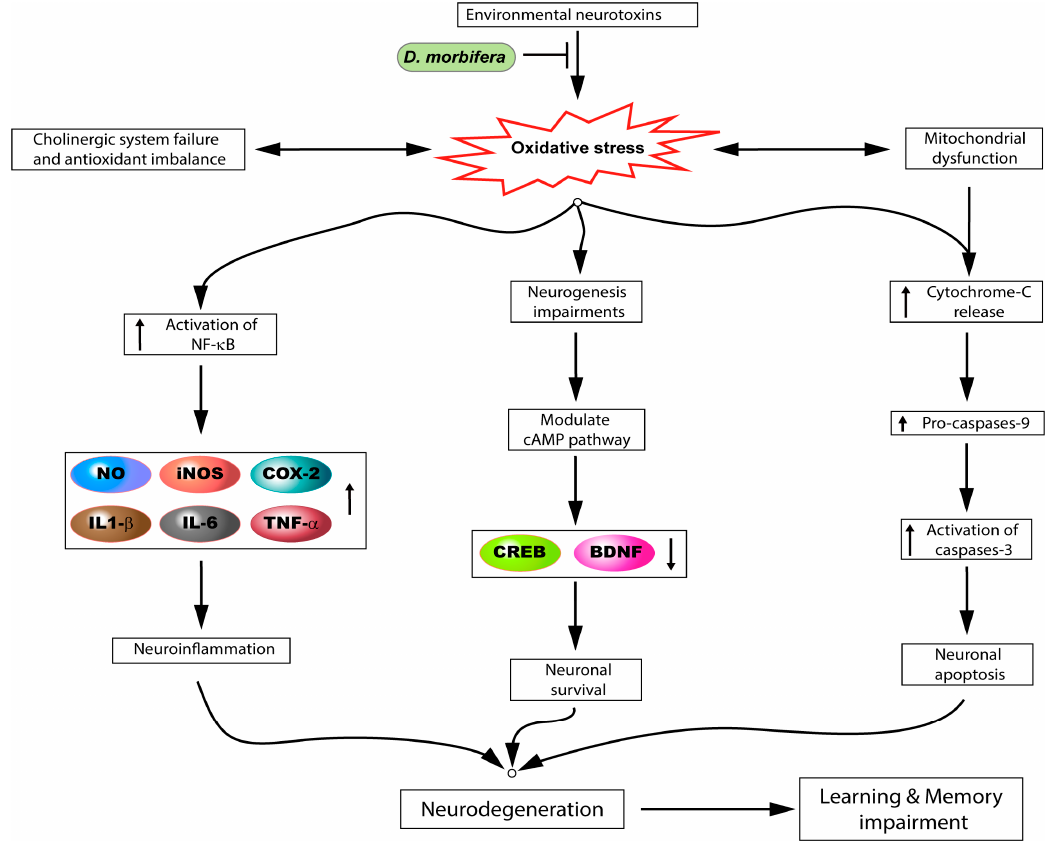
Figure 3. Neuroprotective and memory enhancing effect on D. morbifera . MAPK: mitogen-activated protein kinase; NF κ B: Nuclear factor kappa B; NO: Nitric oxide; iNOS: Inducible nitric oxide synthase; COX-2: Cyclooxygenase-2; IL-1 β : Interleukin 1 beta; IL-6: Interleukin 6; TNF- α : Tumor necrosis factor-alpha; cAMP: Cyclic adenosine monophosphate; CREB: cAMP response element-binding; BDNF: Brain-derived neurotrophic factor.